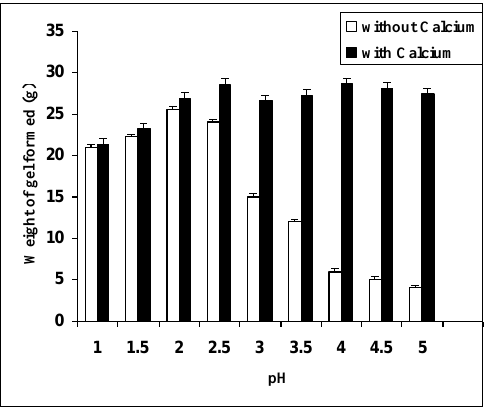
Figure (3): The effect of pH and added 1.6 mM Ca ++ ions on the weight of gel formed from 30 ml solutions (1.0% (w/v) pectin as a function of pH. Each value is the mean ± S.E of 3 determinations.